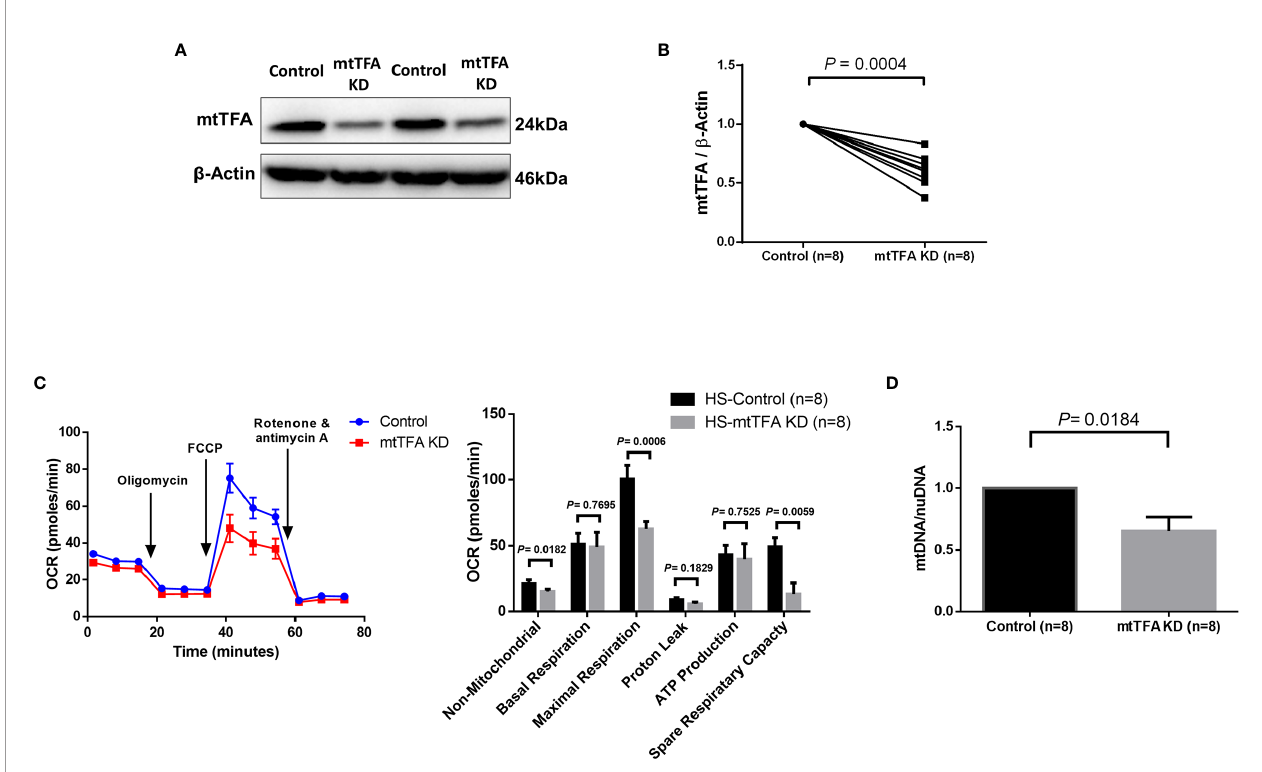
FIGURE 4 | mtTFA Knockdown in CD4 T cells from HS. (A, B) Representative Western blots and summary data of mtTFA and b -actin expression in HS CD4 T cells following CRISPR/Cas9 TFAM KD. (C) Representative OCR summary data for non-mitochondrial, basal respiration, maximal respiration, spare respiration capacity, proton leak, and ATP production in CD4 T cells with or without TFAM KD. (D) Quanti fi cation mitochondrial DNA (mtDNA)/nuclear DNA (nuDNA) content in HS CD4 T cells with or without TFAM KD. DNA content from mtTFA KD was normalized to the control group. KD, knockdown. The data were analyzed by parametric paired T-tests.